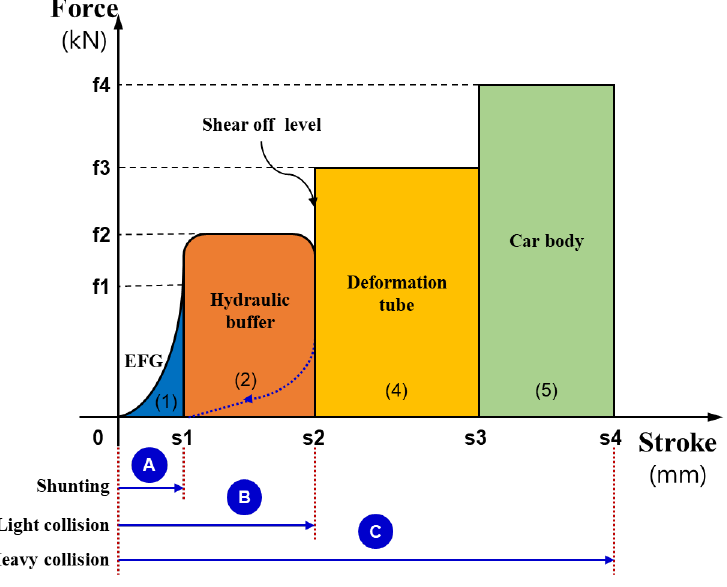
Figure 1. Collision scenario of a coupler system.